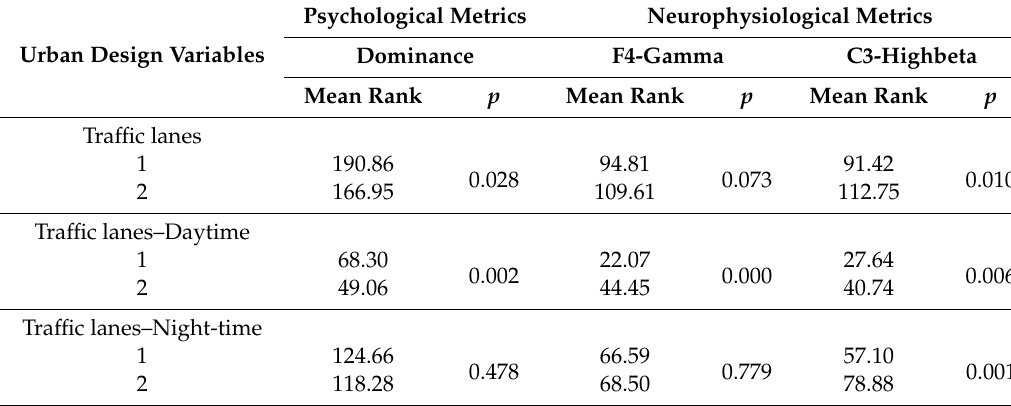
Mann–Whitney U tests for the di ff erences in the mean ranks of psychological and neurophysiological metrics between 1–2 tra ffi c lanes (significance level p < 0.05).